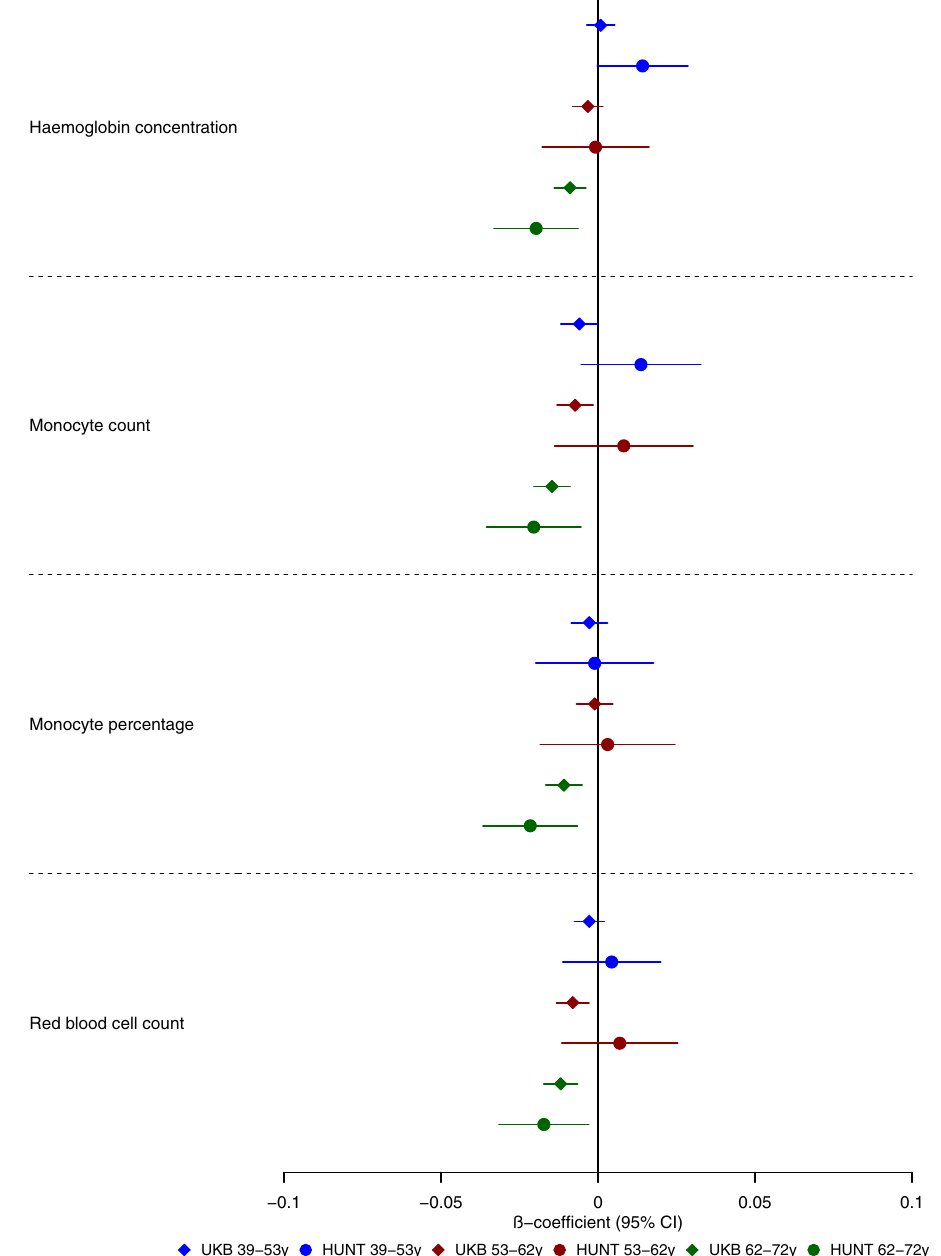
phenotype per 1 unit increase in the standardized polygenic risk score for Alzhei- mer ’ s disease. Error bars represent 95% con fi dence intervals. All statistical tests were two-sided. The HUNT analyses included 7,267 – 18,307 participants for these measures. The UK Biobank analyses included 108,095 – 108,391 participants for blood-basedbiomarkers.Thecon fi denceintervalsaresmallerinUKBiobankdueto the larger sample size of the cohort compared to